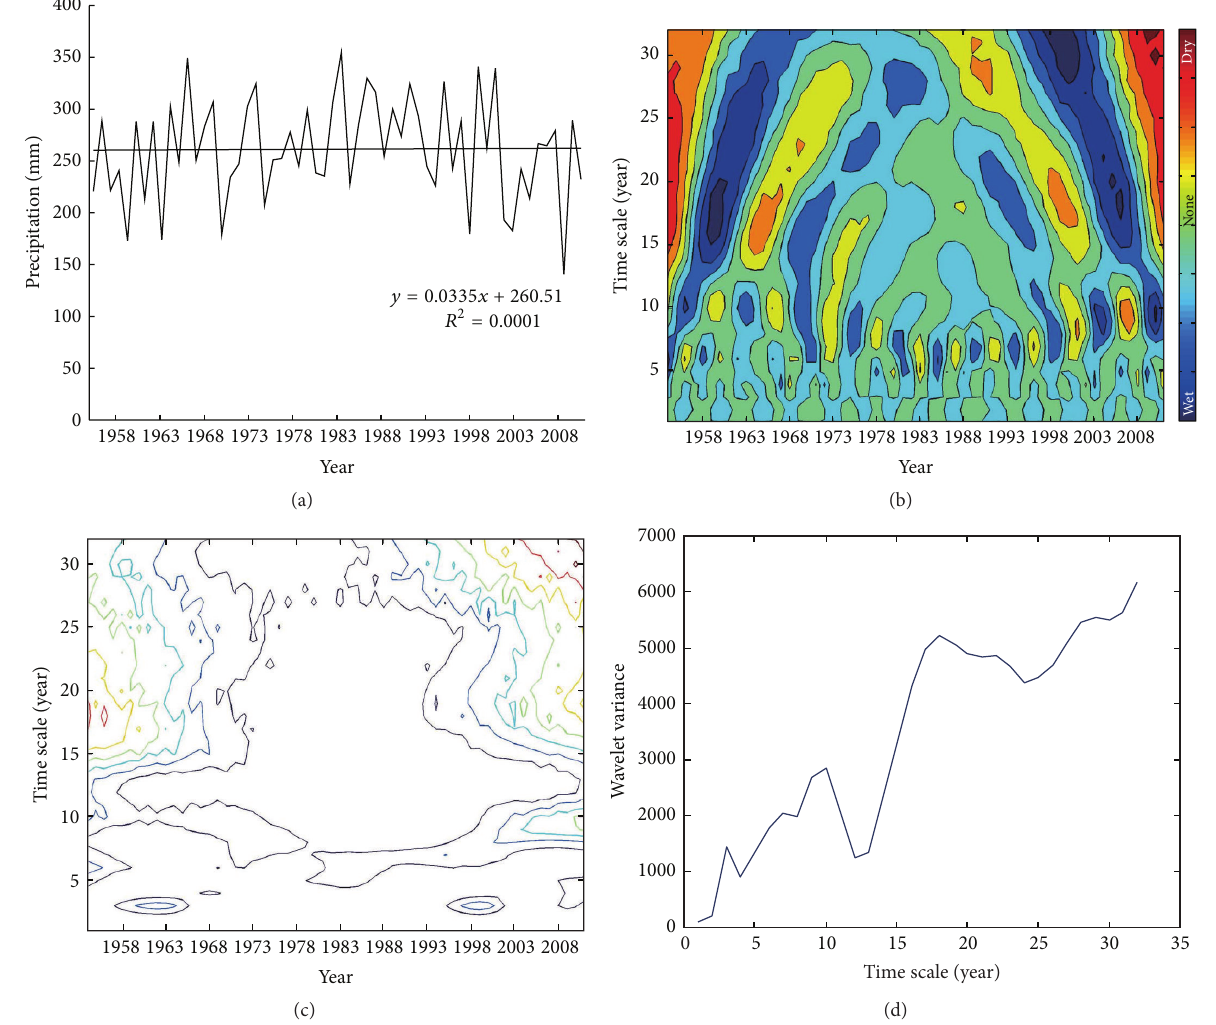
Figure 4: (a) Autumn precipitation interannual change of Yunnan. (b) Autumn precipitation wavelet transform of Yunnan. (c) Autumn preci- pitation wavelet coefficients contour of Yunnan. (d) Autumn precipitation wavelet variance of Yunnan.